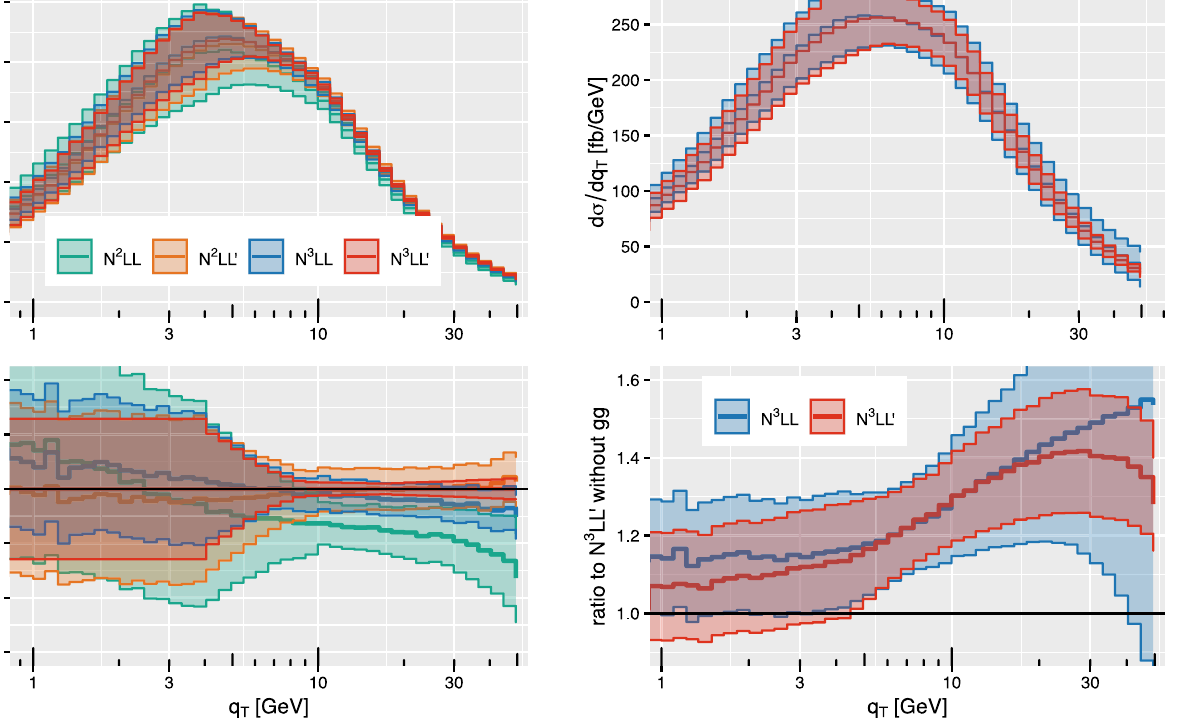
Fig. 2 Resummed q T spectrum without transition function nor match- ing for q ¯ q -initiated hard function at different orders. Top plot: absolute distributions. Bottom plot: ratio to N 3 LL (cid:2)